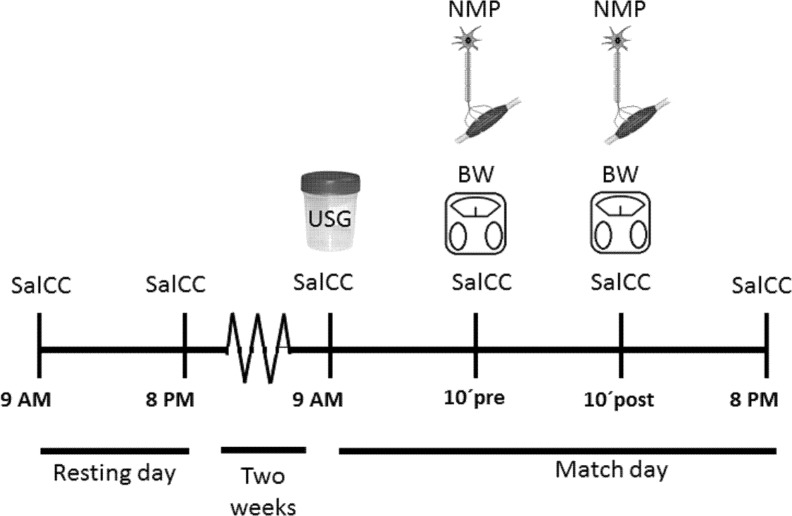
Experimental design.